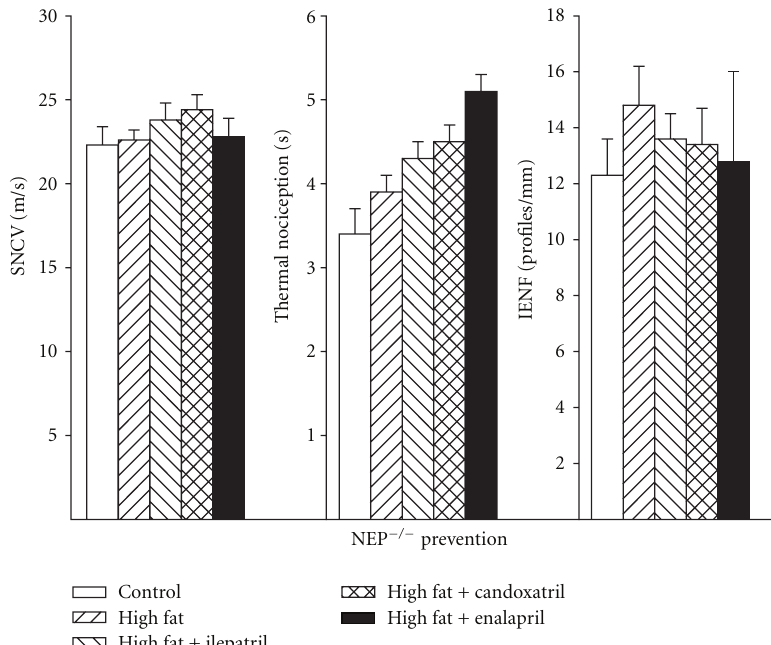
Figure 8: Sensory nerve conduction velocity, thermal nociception, and intraepidermal nerve fiber profiles for NEP − / − mice fed a normal or high-fat-containing diet for 24 weeks with or without ilepatril, candoxatril, or enalapril for the last 12 weeks (intervention protocol). Control (open bar), high fat (right hatch bar), high fat + ilepatril (left hatch bar), high fat + candoxatril (cross hatch bar), and high fat + enalapril (closed bar). Data are the mean ± SEM. The number of mice in each group was the same as shown in Table 2. a, P < 0 . 05 versus control; b, P < 0 . 05 versus high-fat-fed